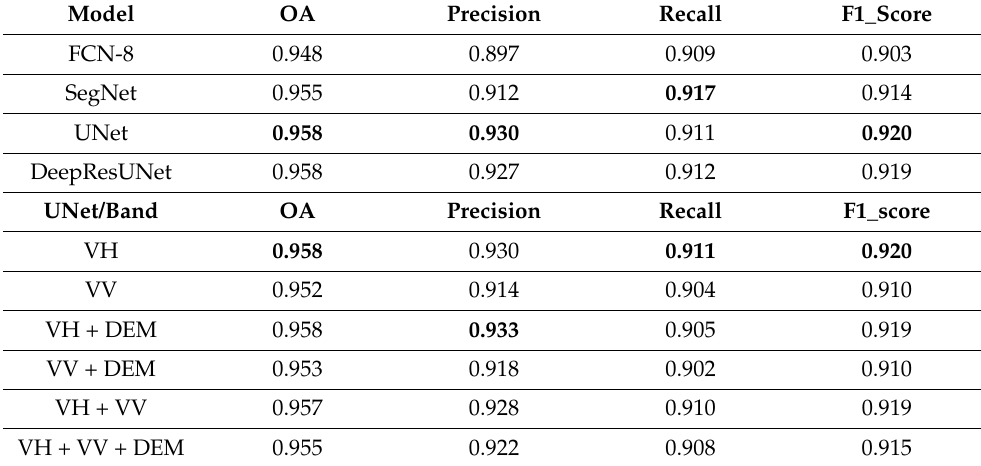
Table 5. Model performances with weak label datasets. Model OA Precision